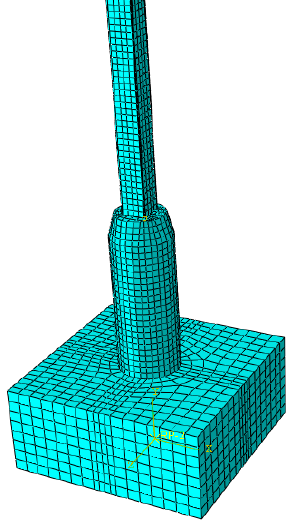
Figure 3. Overall model and mesh division.